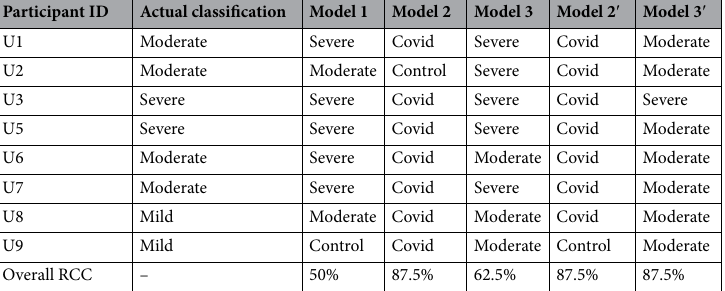
Table 7. Blinded classification of unknown participants. RCC rate of correct